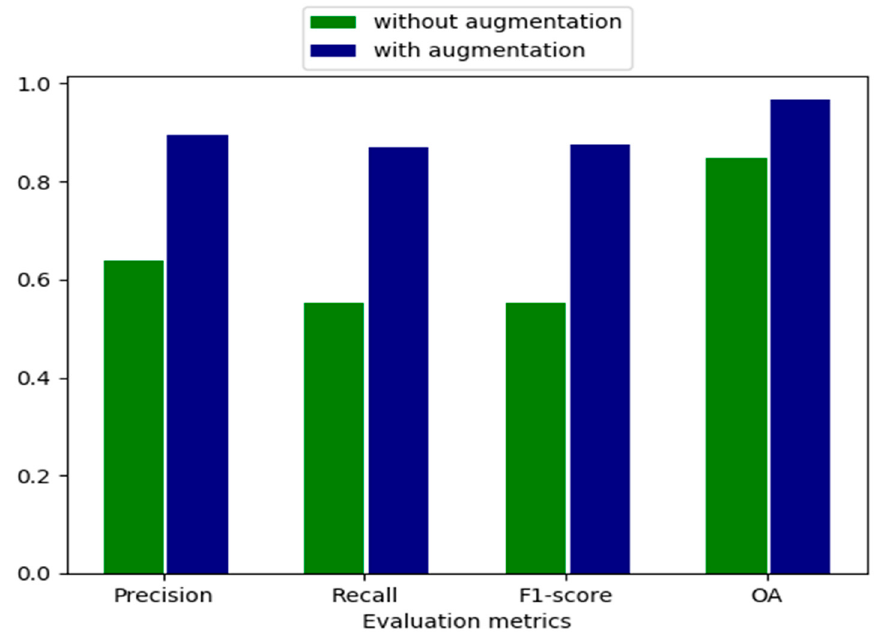
Figure 5. The effect of data augmentation on the accuracy of our proposed CD method in terms of Precision, Recall, F1-score, and OA.